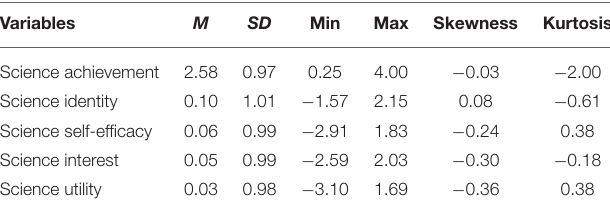
TABLE 1 | Descriptive statistics for the path analysis model variables ( N = 14,815).